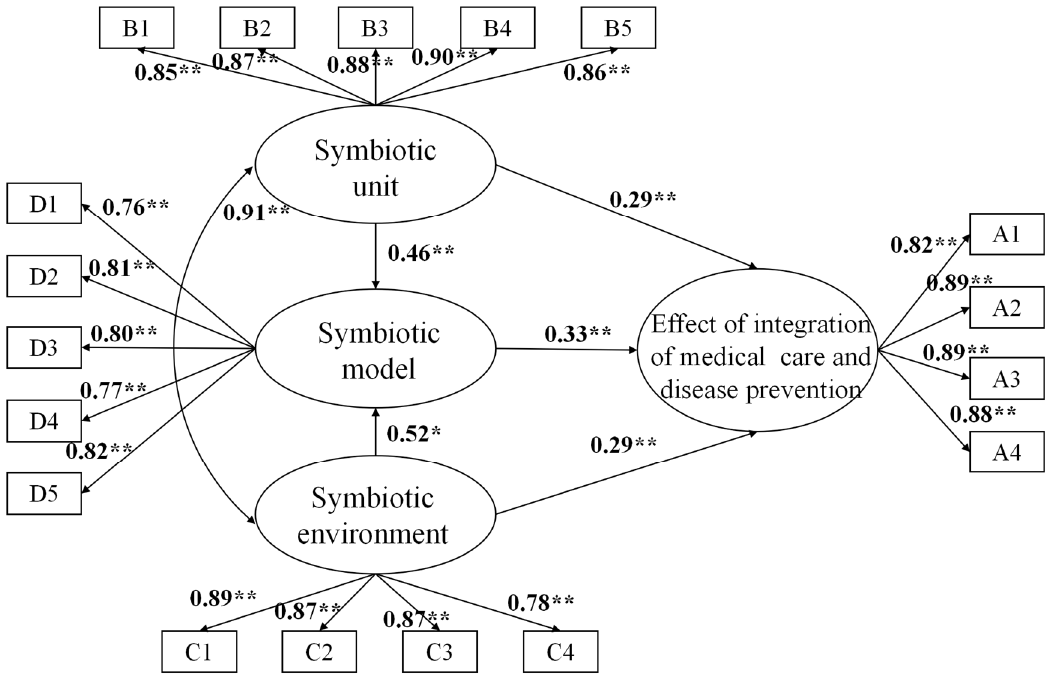
Figure 2. Model of the integration of medical care and disease prevention. Note: ** significant levels of 1%. * significant levels of 5%.